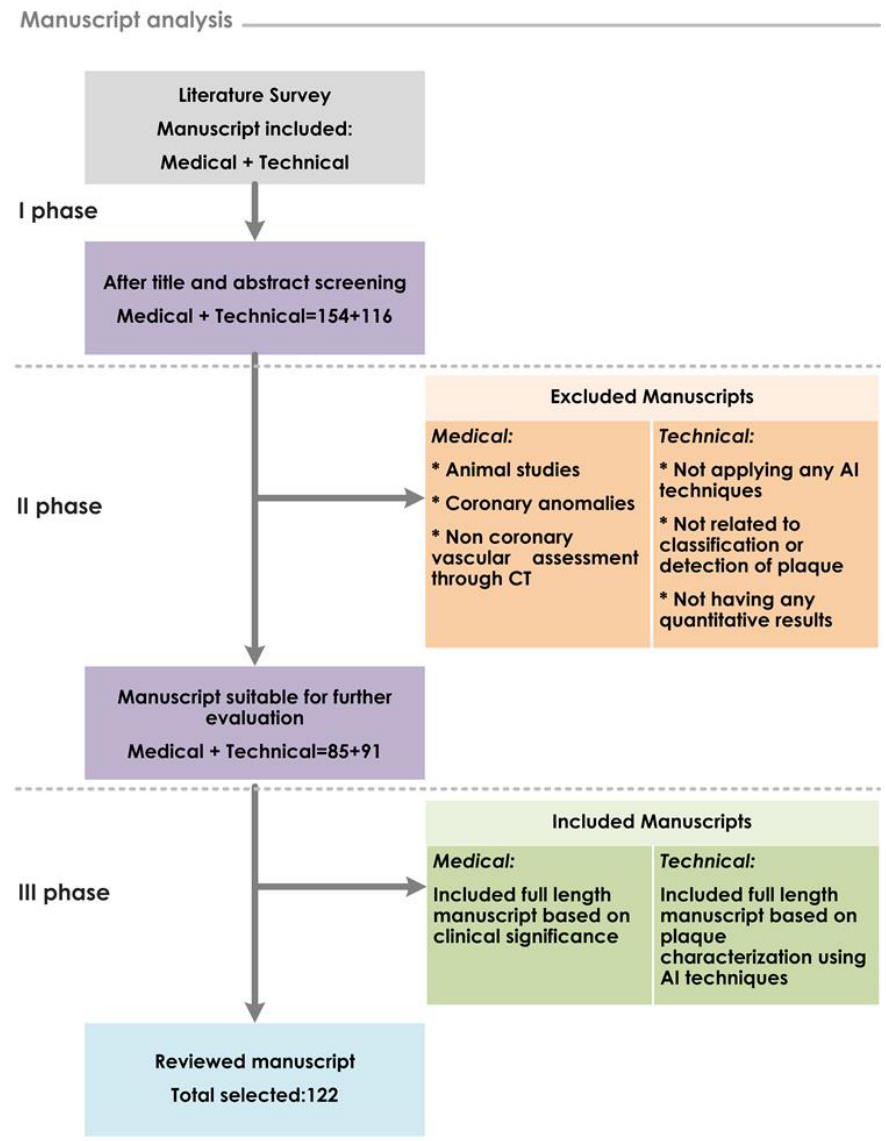
Figure 1. Workflow of study strategy and manuscript selection process.